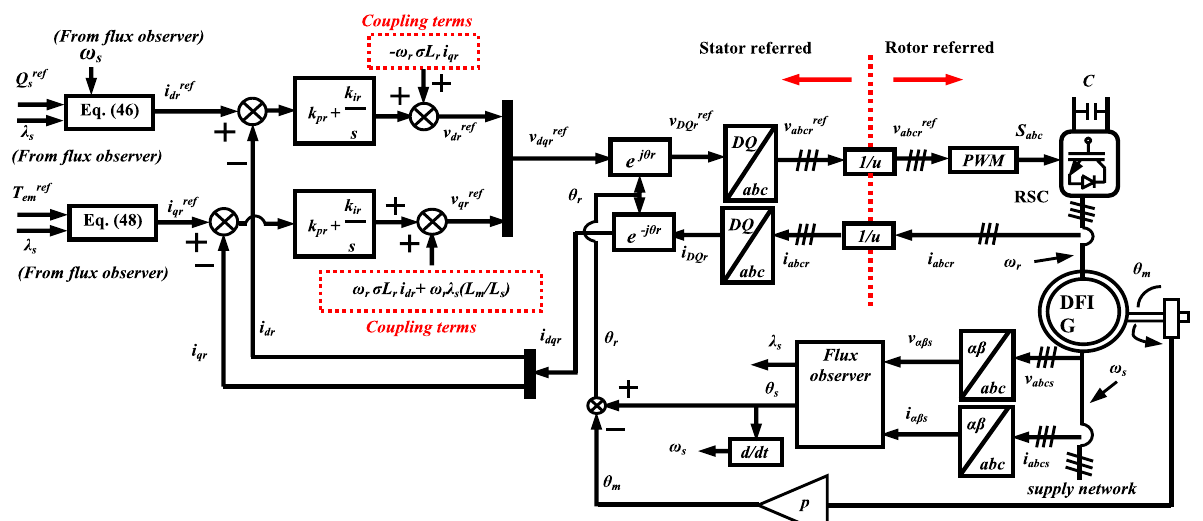
Fig. 10 Vector control of the RSC with speed sensor using the PI controller